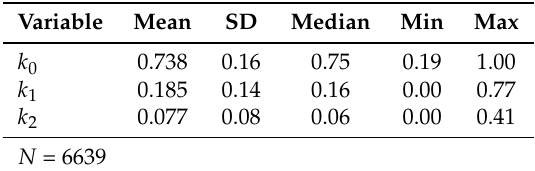
Table 7. Summary of k 0 , k 1 , and k 2 estimates.